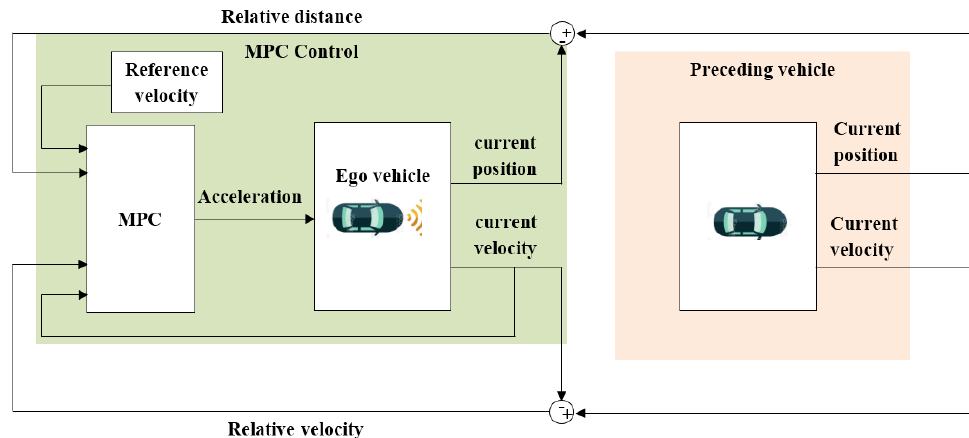
Figure 9. Overall diagram of the control system—MPC